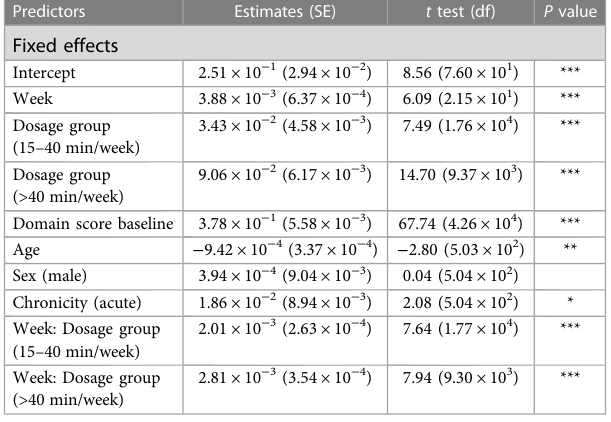
Table 1 . In general, age, sex, and chronicity did not differ among dosage groups ( P > .05 in all comparisons).